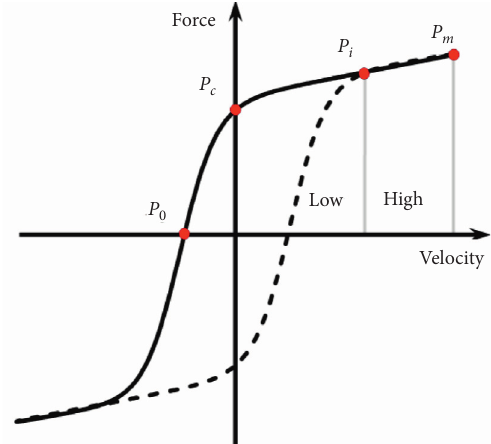
Figure 1: Characteristic points in typical force-velocity